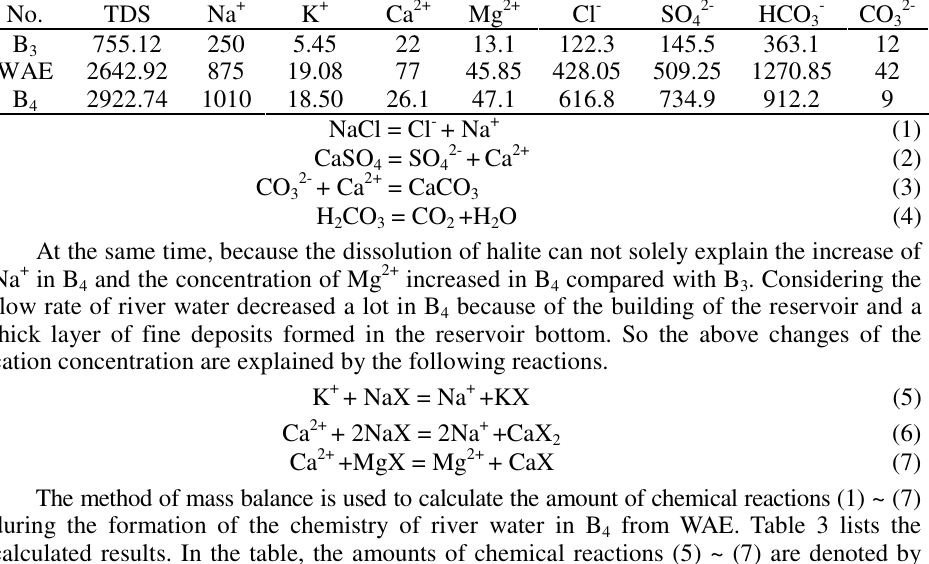
from WAE (Unit: 4